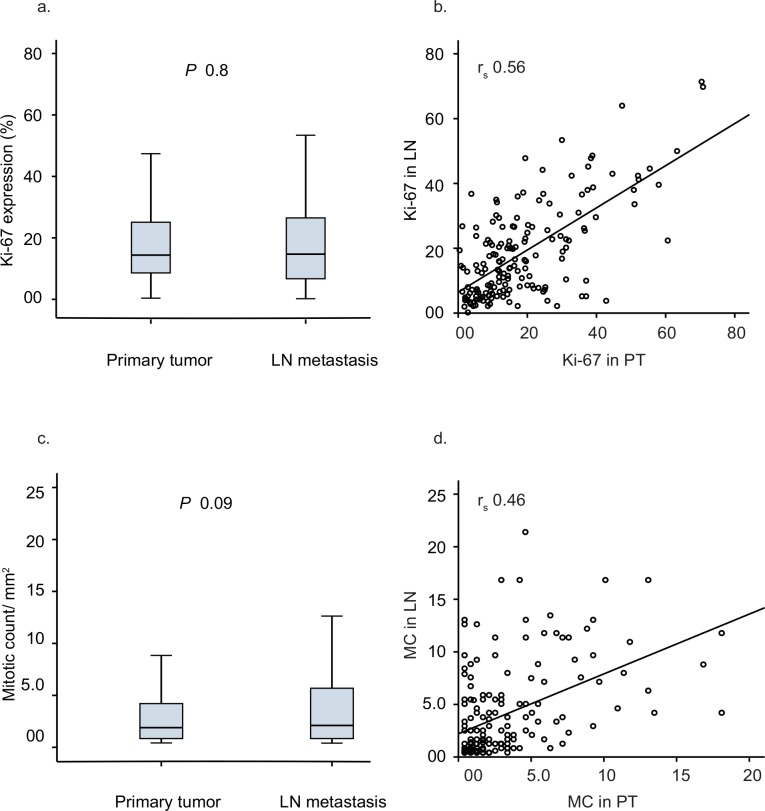
Proliferation markers in primary tumors and lymph node metastases.Box plots (a. and c.) Horizontal lines inside the boxes represent the median values; box limits indicate the 25th and 75th percentiles. Scatter plot (b. and d.) for % Ki-67 and MC in PT and LN metastasis.